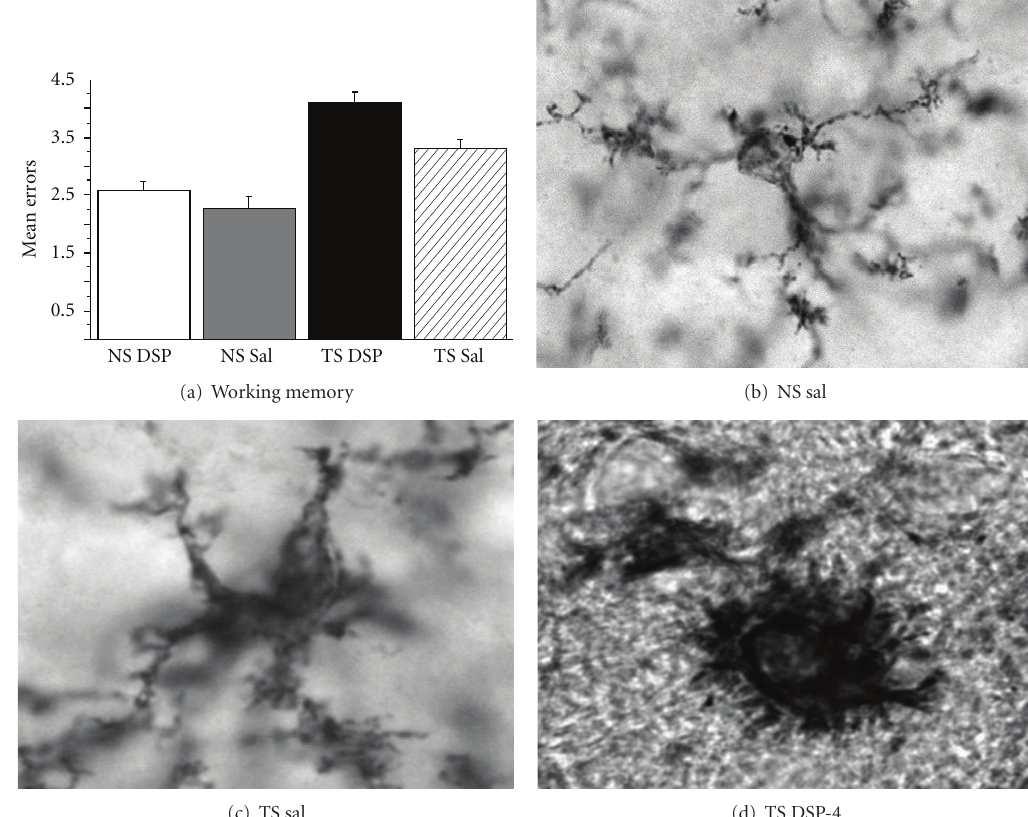
Figure 3: E ff ects of the NE neurotoxin DSP-4 on Ts65Dn and normosomic mice. Note significant aggravation of performance in a memory task (a) coupled with aggravated activation of microglial cells (b–d) in the hippocampal formation, as evidenced by Cd45 immunohistochemistry. (a) Average number of errors in a water radial arm maze. The NE lesion exhibited more pronounced e ff ects on errors in the maze in TS than in NS mice, and TS mice performed more errors than NS mice, regardless of NE lesions (DSP) or not (Sal). (b–d) Cd45 staining of microglial cells in the hippocampus in a normosomic mouse (NS) treated with saline (b), a Ts65Dn mice on saline (c), and a Ts65Dn mouse that received DSP-4 lesions of the LC-NE neurons (d). Note significant activation of individual microglial cells as a result of the NE lesion in TS mice compared to controls. Quantitation of inflammatory processes is available in Lockrow et al., 2011